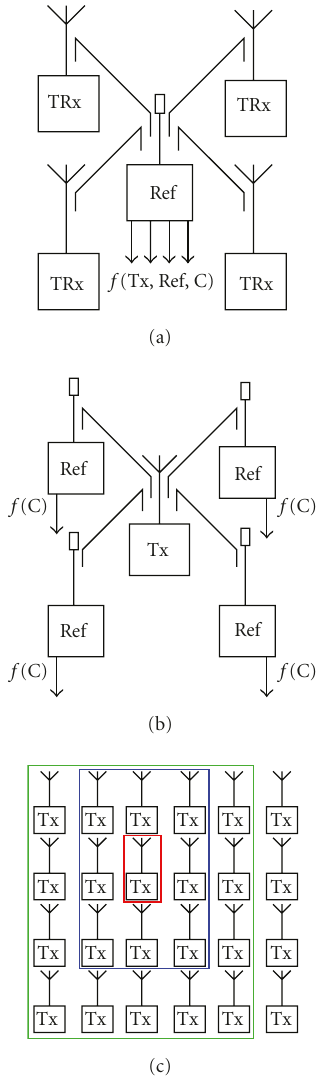
Figure 25: The two main processes of our heuristic method: (a) reference characterisation and (b) transmitter characterisation. (c) The error dependency spreads from the neighbouring elements with each iteration of the heuristic